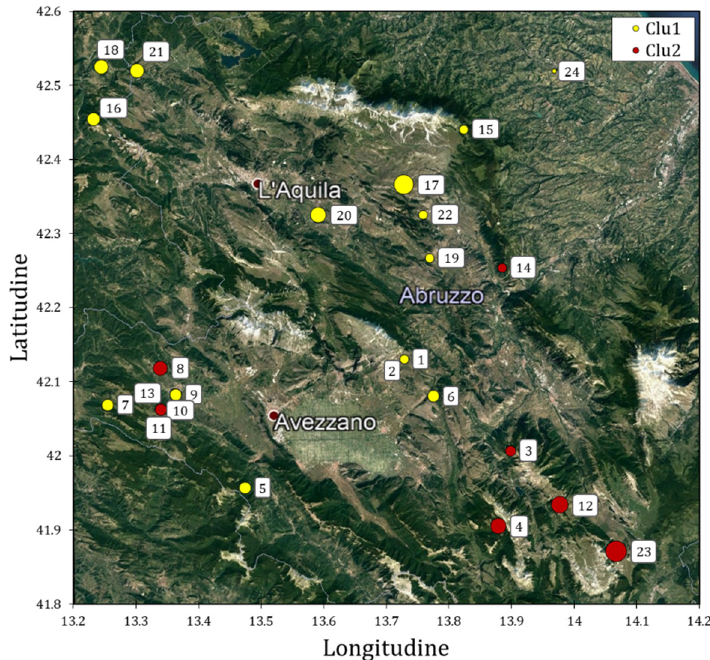
Figure 1. Geographical location of 24 Solina accessions collected in 2018 in the Abruzzo region colored on the basis of their genetic clusters identified by DArT markers analysis (see Sections 3 and 4). The diameters of yellow and red circles are correlated to the altitude of the site of seed collection. Dark red dots with a white border represent the most important cities of the area.